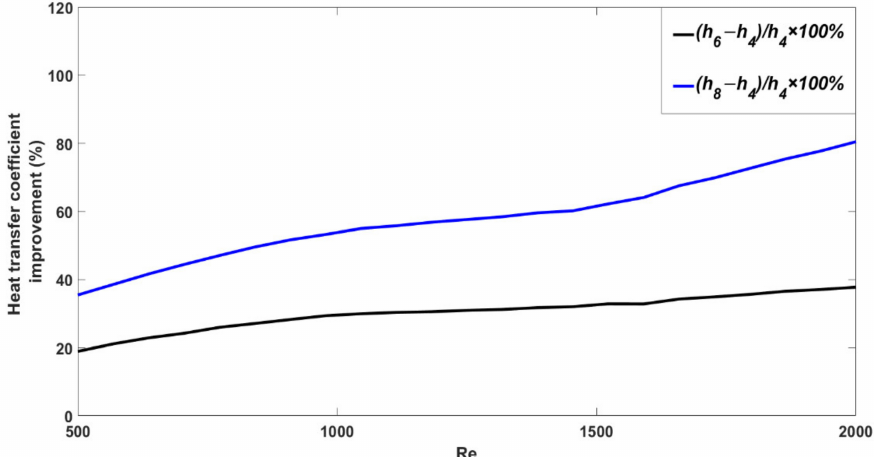
Figure 5. Relative increase in heat transfer coefficient for channels with turns numbers of 6 and 8 with respect to